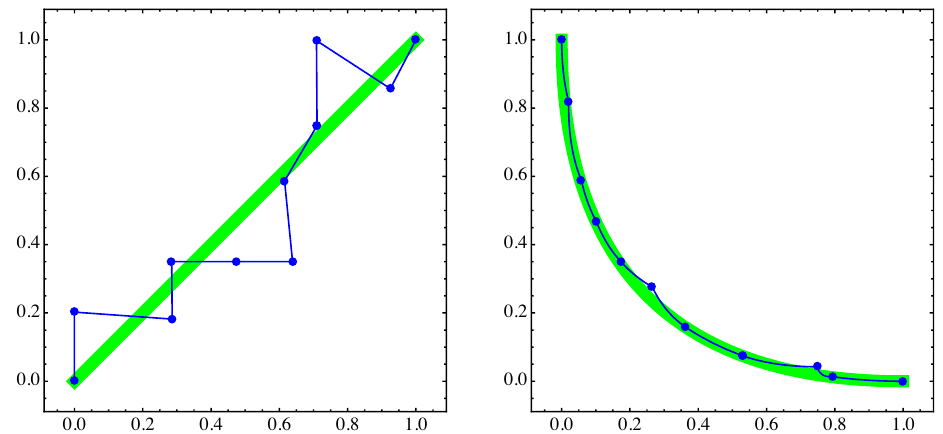
Figure 9. Left: approximations A (blue dots) corresponding to the 500th generation of the NSGA-II algorithm, and B (blue polygon line) of the Pareto set (green thick line) of MOP (12) for n = 2. Right: respective approximations F ( A ) and F ( B ) of the Pareto front for γ = 2.